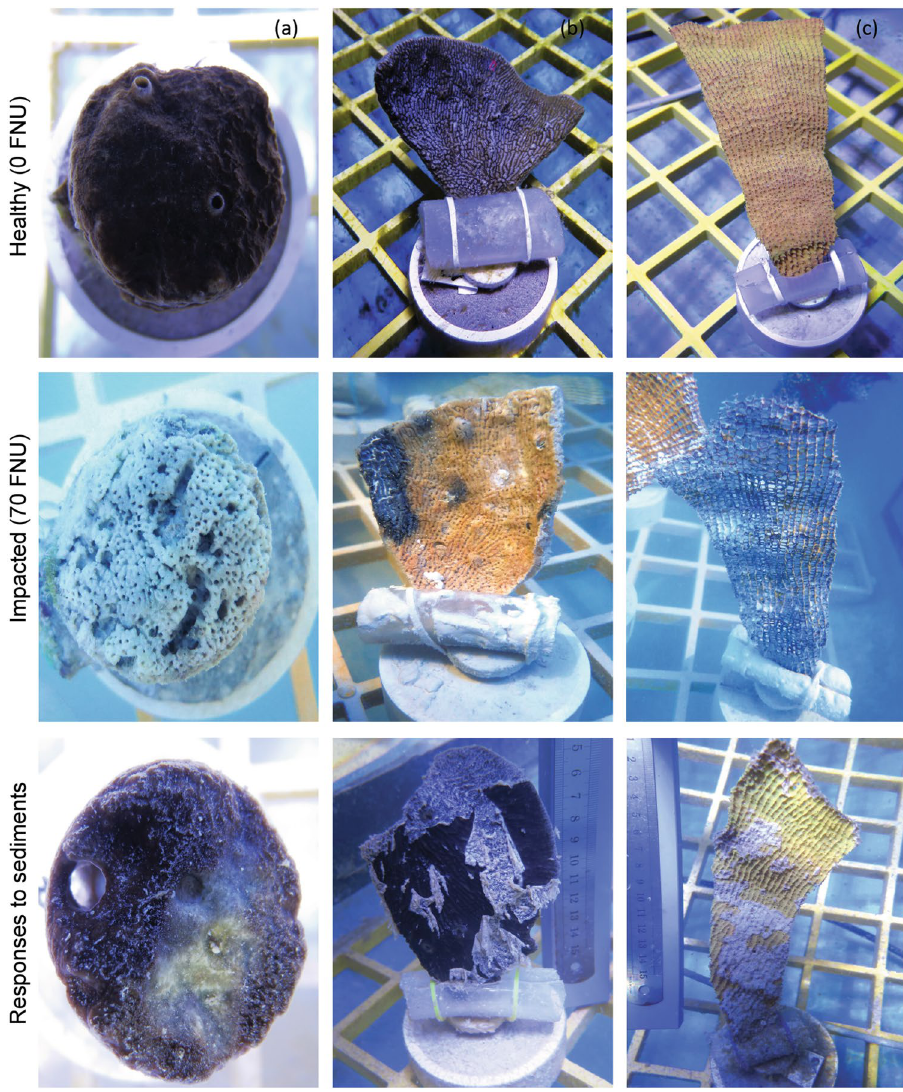
Figure 3. Sponge behavioural responses to sediments. ( a ) C . orientalis , ( b ) C . foliascens , and ( c ) I . basta . Healthy and impacted sponges under the control (0 FNU) and highest turbidity scenario (70 FNU), respectively, and their visual responses to sediment stress (i.e. oscula closure, mucus production and tissue Pigment analysis. Chl a concentration was highly correlated to total chlorophyll in both C . orientalis and C . foliascens (R 2 = 0.997 and 0.998 and P < 0.001, respectively). In addition, Chl a was highly correlated to Chl c in C . orientalis and negatively correlated to Chl d in C . foliascens (R 2 = 0.993, − 0.392 and P < 0.001, respec- tively). Overall, concentrations of Chl a were stable throughout the experiment in the controls and lower tur- bidity scenarios ( ≤ 3 FNU) (Fig. 4b). However, significantly lower concentrations of Chl a were observed under higher turbidity scenarios ( ≥ 30 FNU) at the end of the experimental period for both species (Fig. 4b, Table 4b). Accordingly, Chl c in C . orientalis also decreased significantly in the 70 FNU scenario (ANOVA: P < 0.001) at the end of the experimental period (Supplementary Fig. S2). At the end of the 14 d observational period, C . orientalis did not show any significant differences between scenarios, consistent with a recovery of its original health status, colour and quantum yields after temporary bleaching (Fig. 4b, Table 4b, Fig. S2). C . foliascens did not recover during the observational period, and significantly lower values of Chl a were retrieved from scenarios ≥ 10 FNU (Fig. 4b, Table 4b). However, the negative correlation between Chl a and Chl d in C . foliascens , and a significant increase in Chl d in samples exposed to ≥ 30 FNU scenarios (ANOVA: P < 0.001), suggests an increase in some Chl d -containing Cyanobacteria under the higher turbidity scenarios (Fig. S2). Non-metric Multi-Dimensional Scaling (nMDS) analysis of normalized data for all pigments retrieved by spectrophotometry (Chl a , Chl b , Chl c , Chl d , Total Chlorophyll and Carotenoids) showed some grouping of the samples according to scenarios for both species (Fig. 4c). This was most evident for C . foliascens exposed to ≥ 10 FNU (Fig. 4c), which is consistent with patterns observed for Chl a . PERMANOVA analysis confirmed